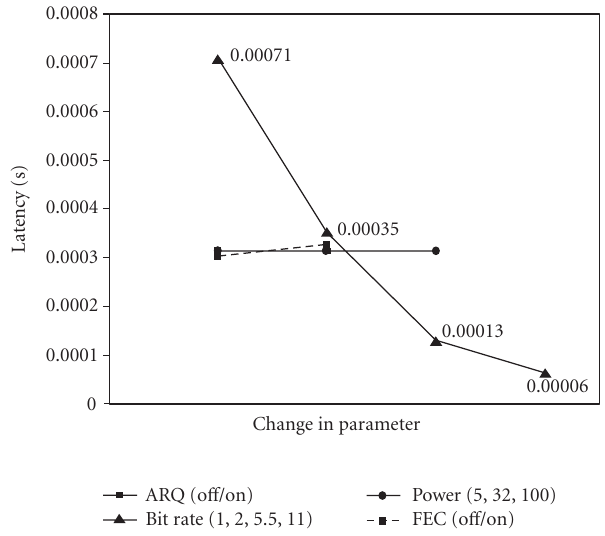
Figure 9: VoIP latency versus average a ff ect of a parameter.